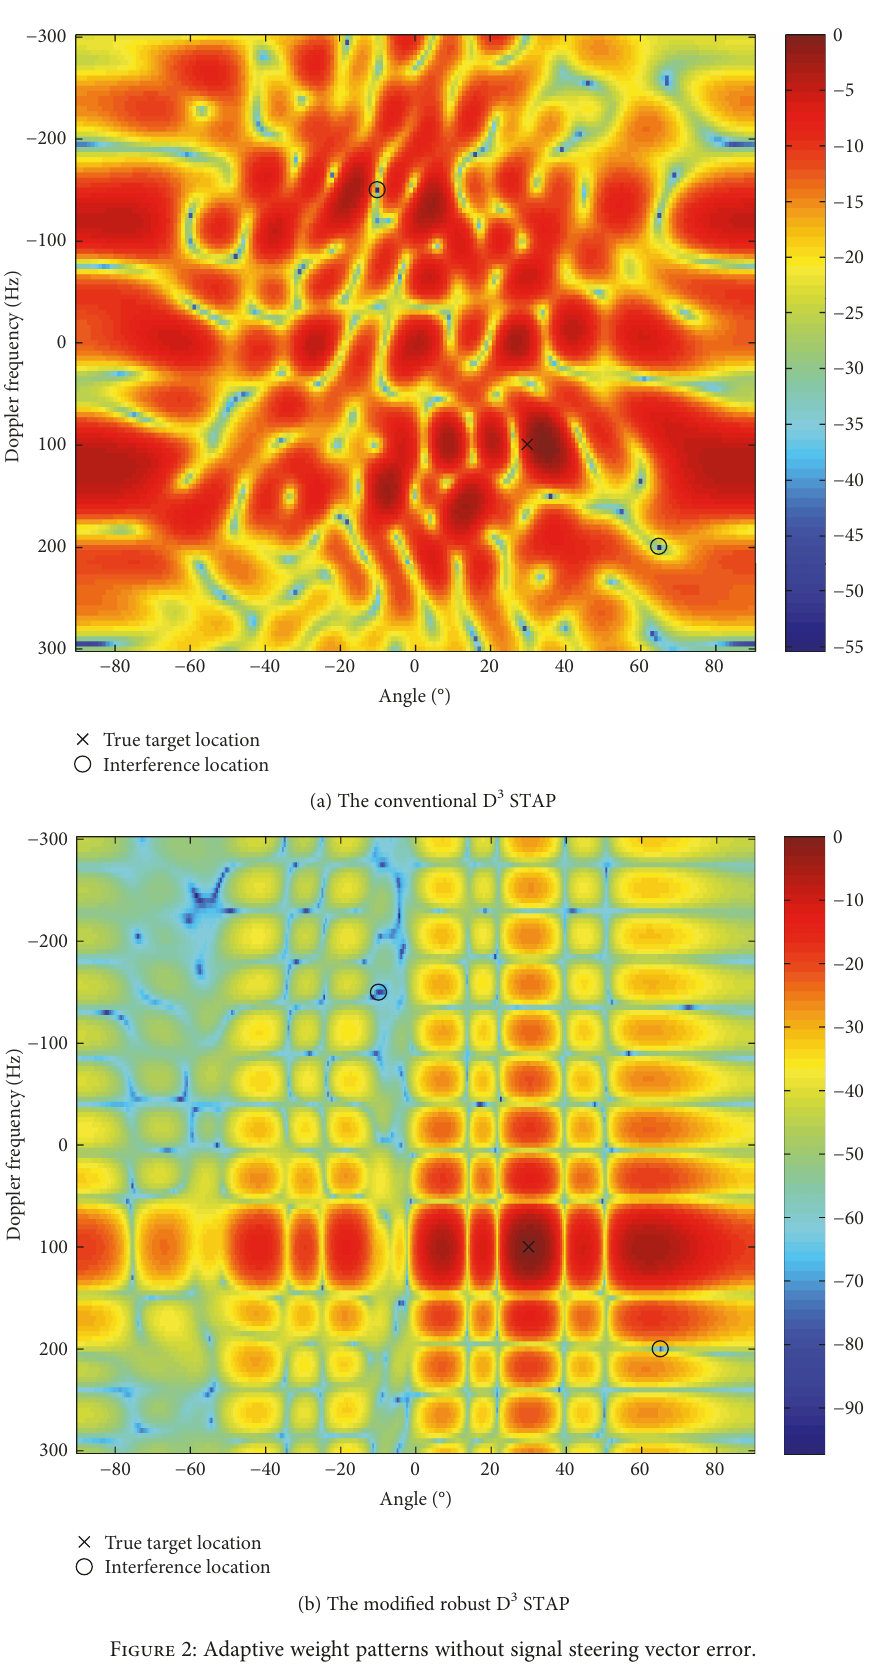
Figure 2: Adaptive weight patterns without signal steering vector